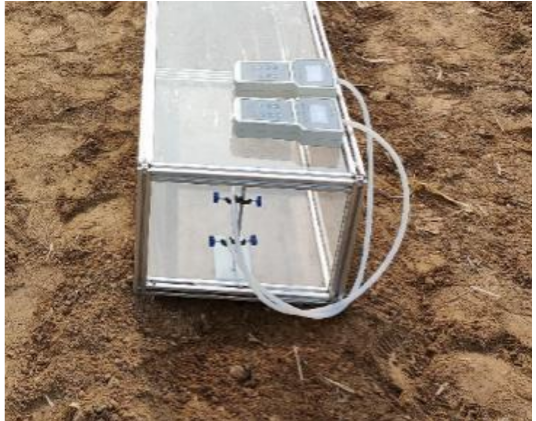
Figure 8. Installation of dust measuring instrument.